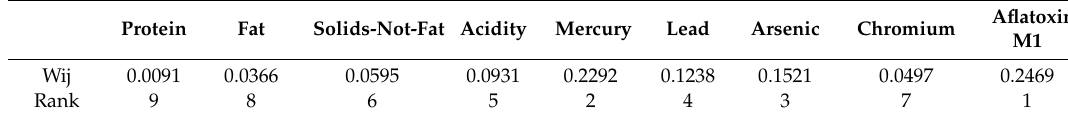
Table 4. Entropy weight of the evaluation indicators.